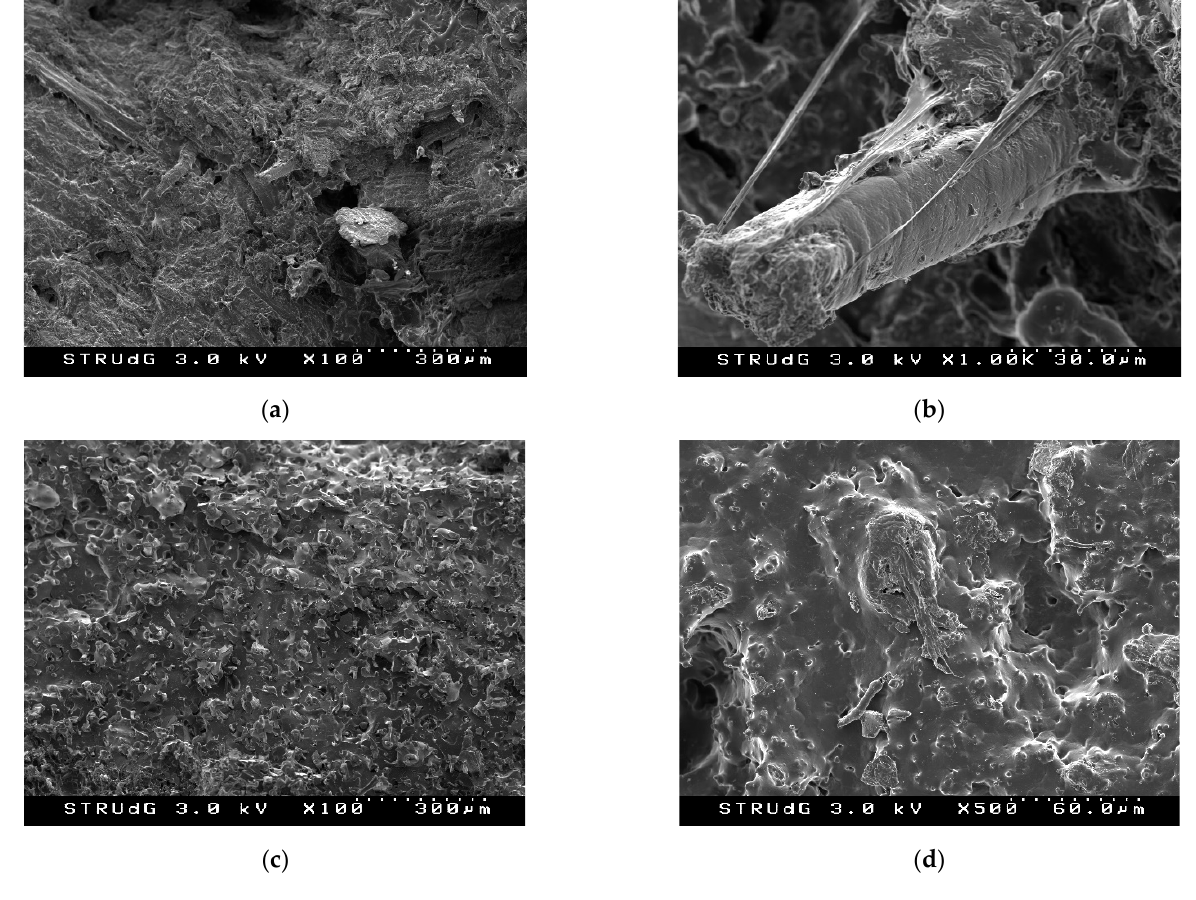
Figure 5. Scanning electron microscopy images of: ( a , b ) TPL/PCL blend reinforced with 30 wt.% SGW fibers, and ( c , d ) TPL/PCL blend.